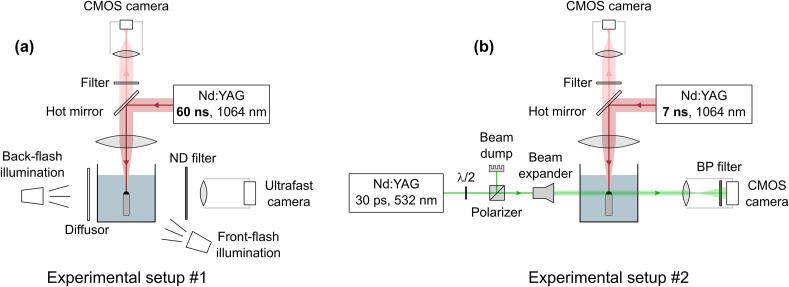
Experimental setups for (a) cinematography by diffuse illumination and for (b) ultrashort shadowgraphy by collimated illumination.